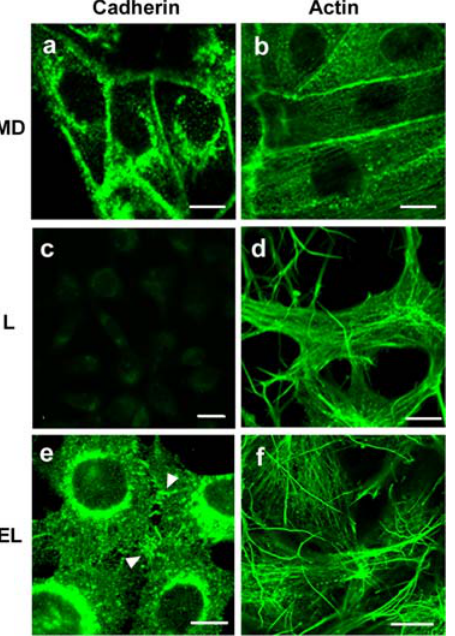
Figure 8. Cadherin and actin distribution in different cell lines. (A) MDCK cells (panels a and b), L cells (panels c and d) and EL cells (panels e and f) were fixed, permeabilized and stained with anti-E- cadherin antibody (left panels) or fluorescently conjugated phalloidin to detect F-actin (right panels). Arrows in panel e point to examples of cadherin junctions at sites of cell–cell contact. Scale bars=10 m m.